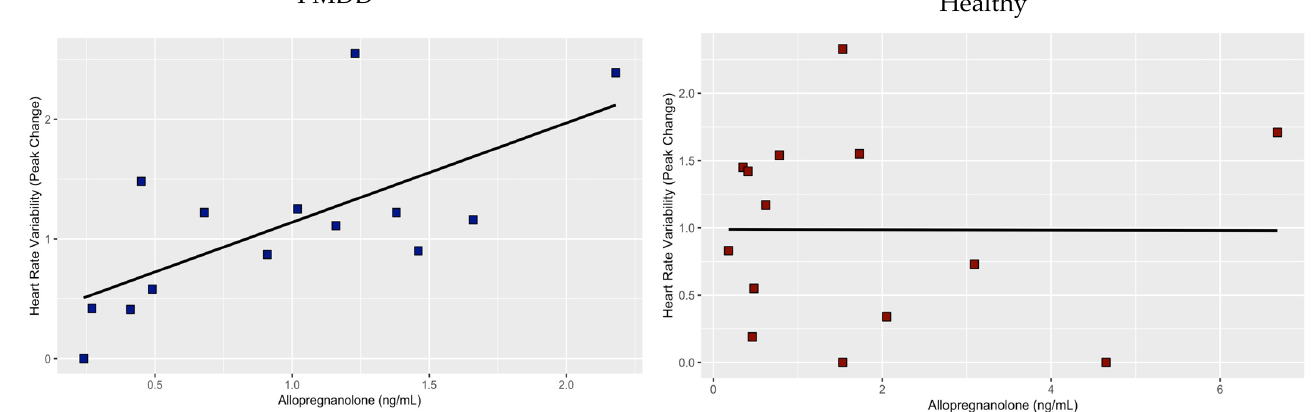
Figure 2. Association between HRV as peak change form baseline and baseline allopregnanolone in PMDD ( left ) and healthy ( right ) study participants. Whereas the association is significant in the PMDD group ( p ≤ 0.01), this association was not identified in the healthy control group.